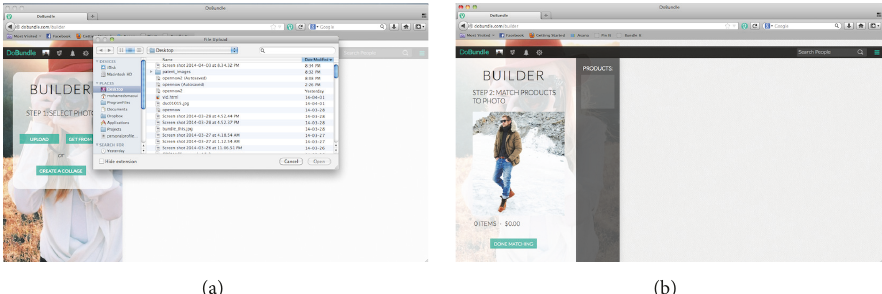
Figure 4: Selecting a “Hook” image. (a) A online store can upload a photo from their computer or include a link to the image if it is on the web. (b) After a user selects an image, it is displayed on their screen.